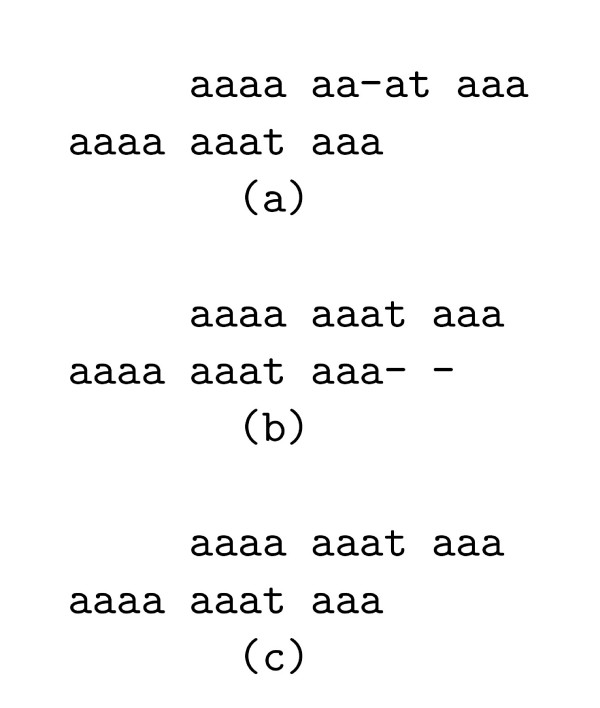
The alignment for π(sB).